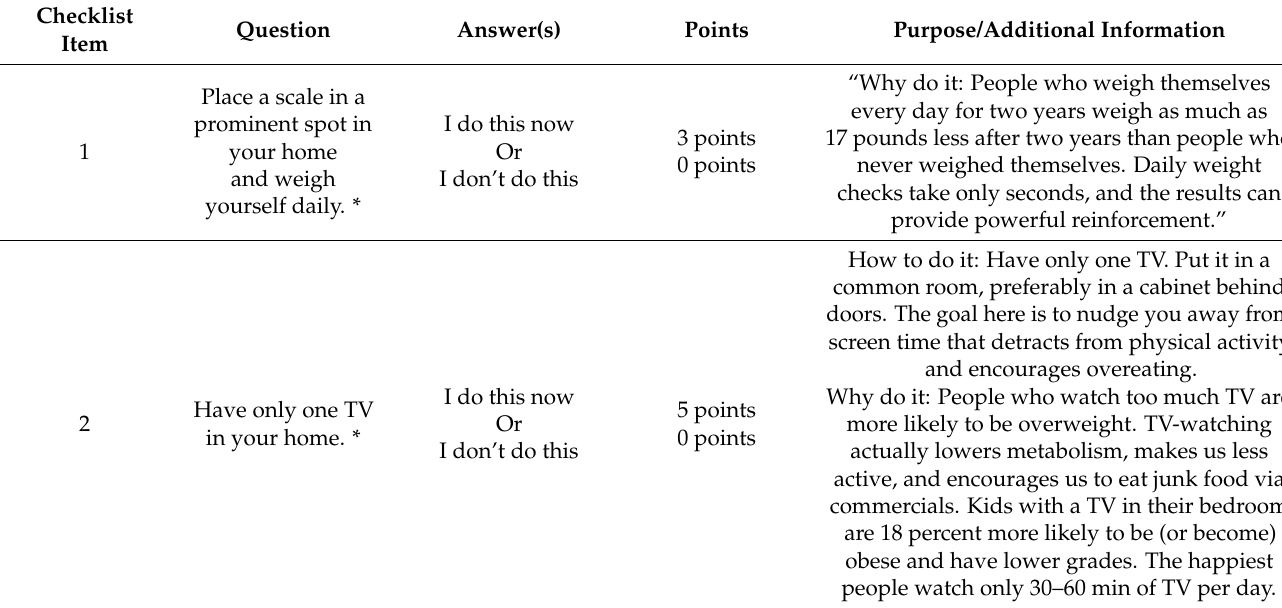
Table 1. Questions from the “Home” checklist